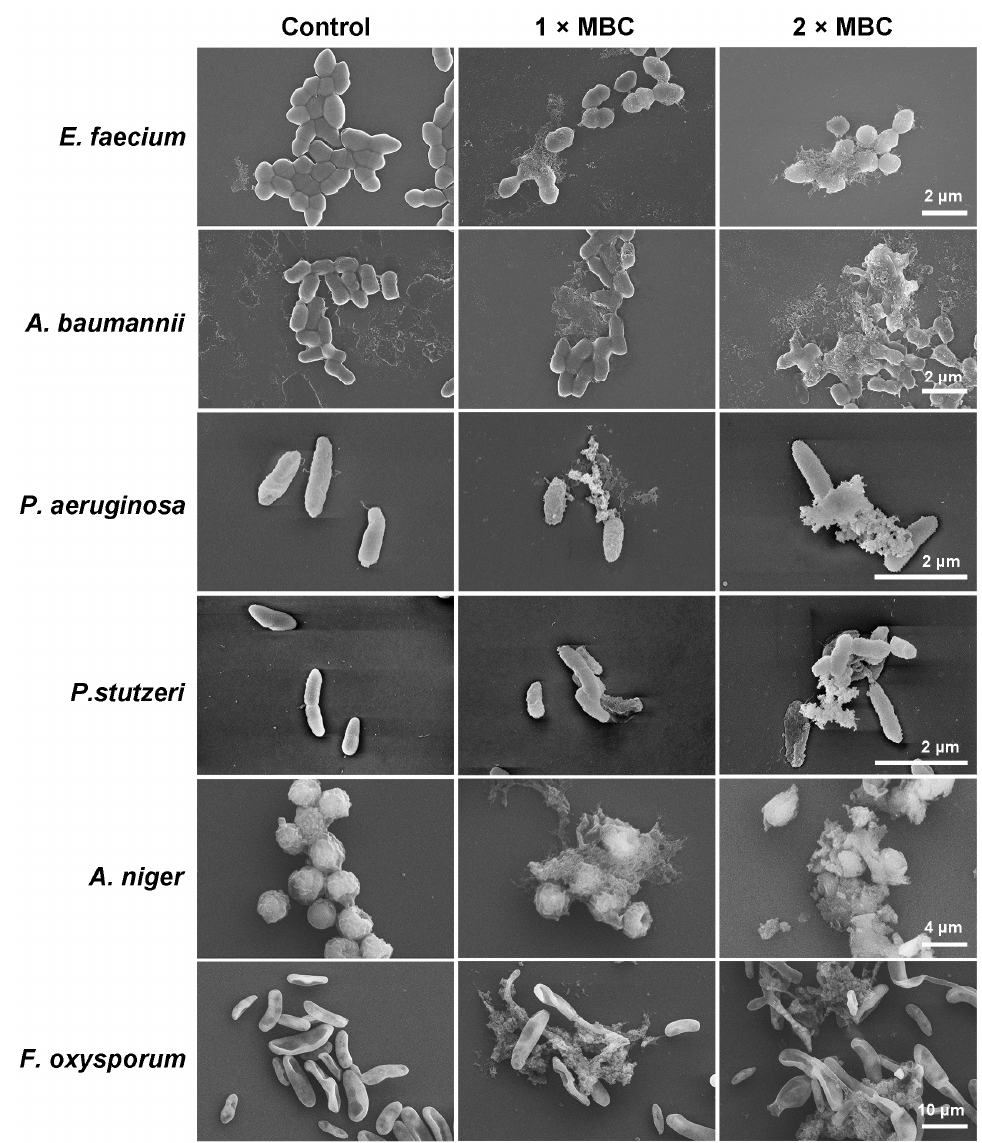
Figure 1. Effect of Sp-LECin on morphological and structural changes of E. faecium , A. baumannii , P. aeruginosa , P. stutzer, A. niger and F. oxysporum observed by a scanning electron microscopy (SEM).